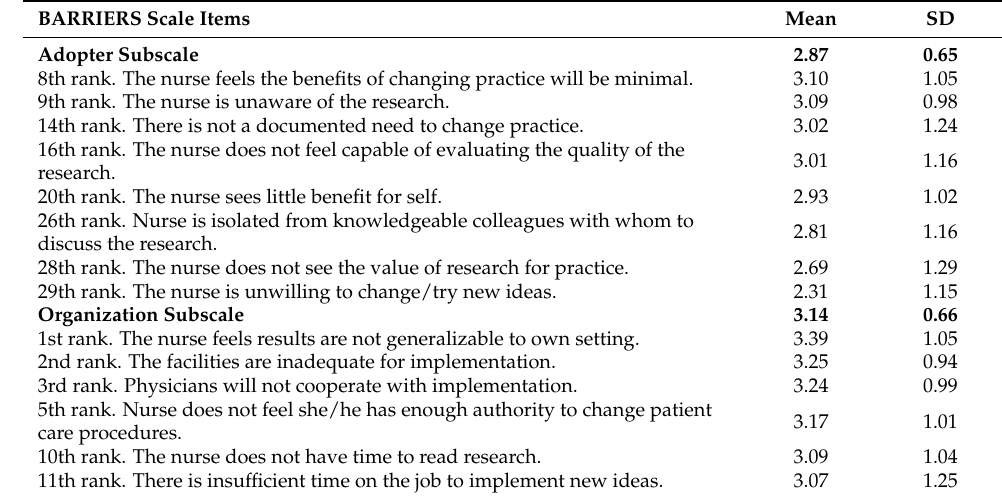
Table 1. Nurses’ Perceived Barriers to Implementing EBP ( n =